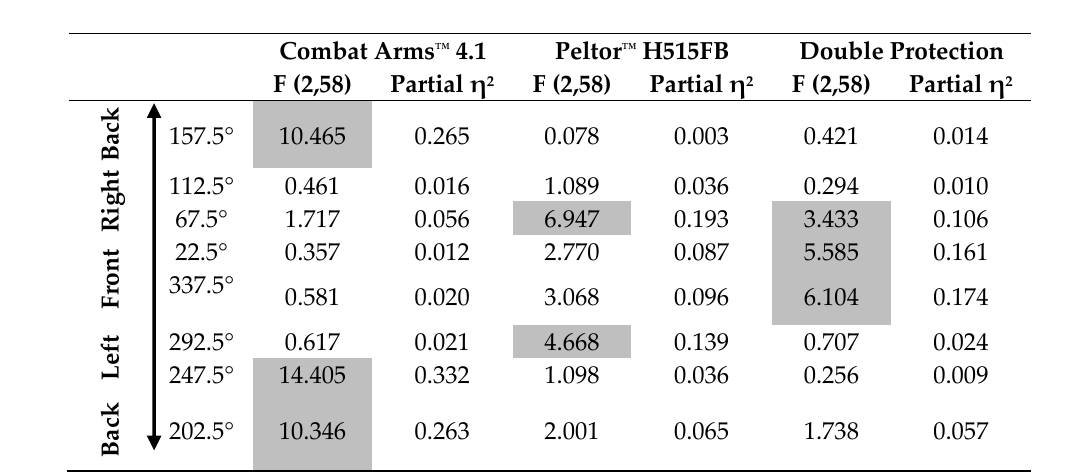
Table 3. Main effects for comparison between stimuli using different HPDs and from different source angles.